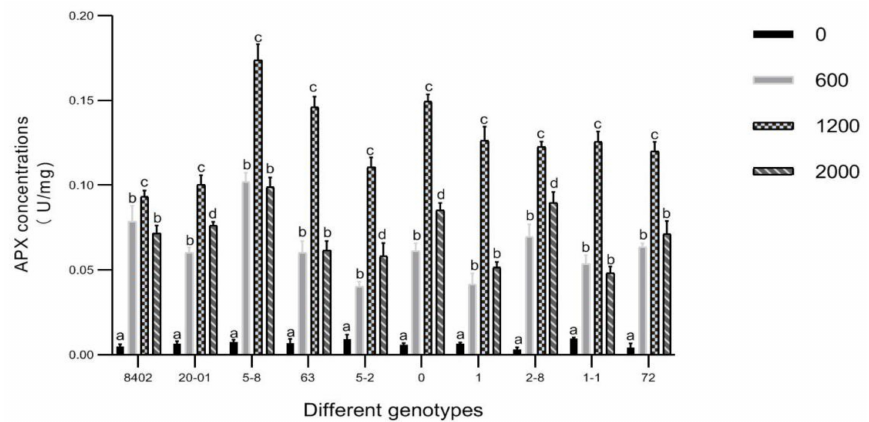
Figure 15. Ascorbate peroxidase (APX) activity in leaves of C. bungei .